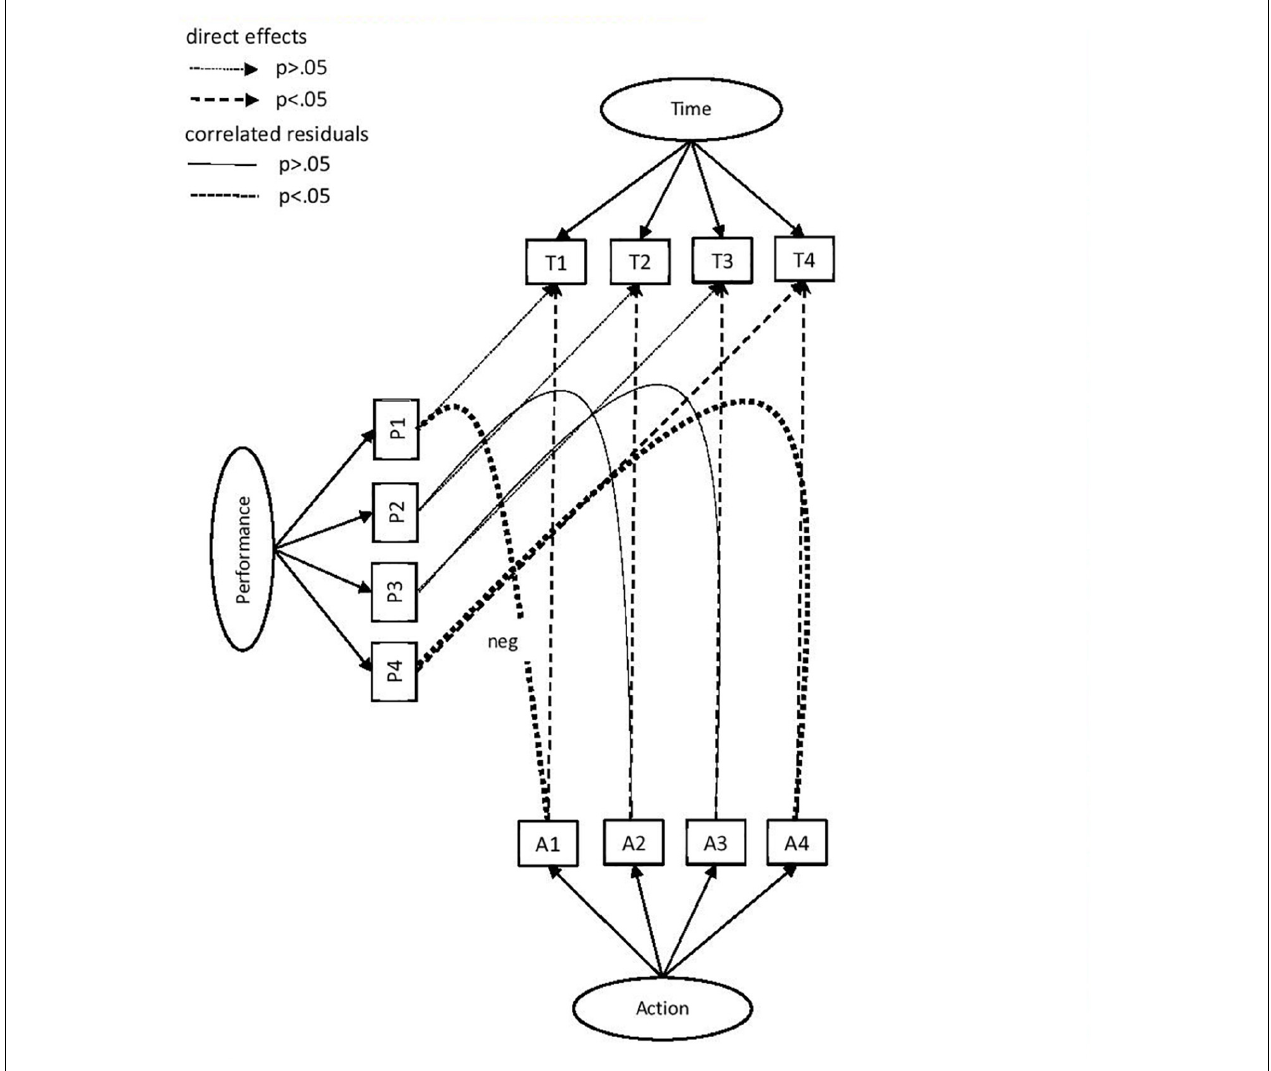
FIGURE 1 | Latent variable and dependency model for Xandar data. The latent variables are Time, Actions, and Performance. The observed variables per factor are indicated with capital letters referring to the latent variable (T, A, P) and with a number referring to the Xandar part (1, 2, 3, and 4). The direct effects between observed variables from the same Xandar part are indicated with single headed dashed arrows (between the A and T and between the P and T). The correlated residuals are indicated with dotted lines without arrow. Significance ( p < –01) is denoted with a thicker dashed arrow (direct effects) or line (correlated residuals). All dependencies are positive except when indicated with “neg” (between Al and PI). Correlations between latent variables, factor loadings, residual variances, and dependency values are omitted to avoid clutter in the figure. The correlations between the latent variables can be found in the text, the factor loadings are presented in Table 3 , and the dependency values in Table 4